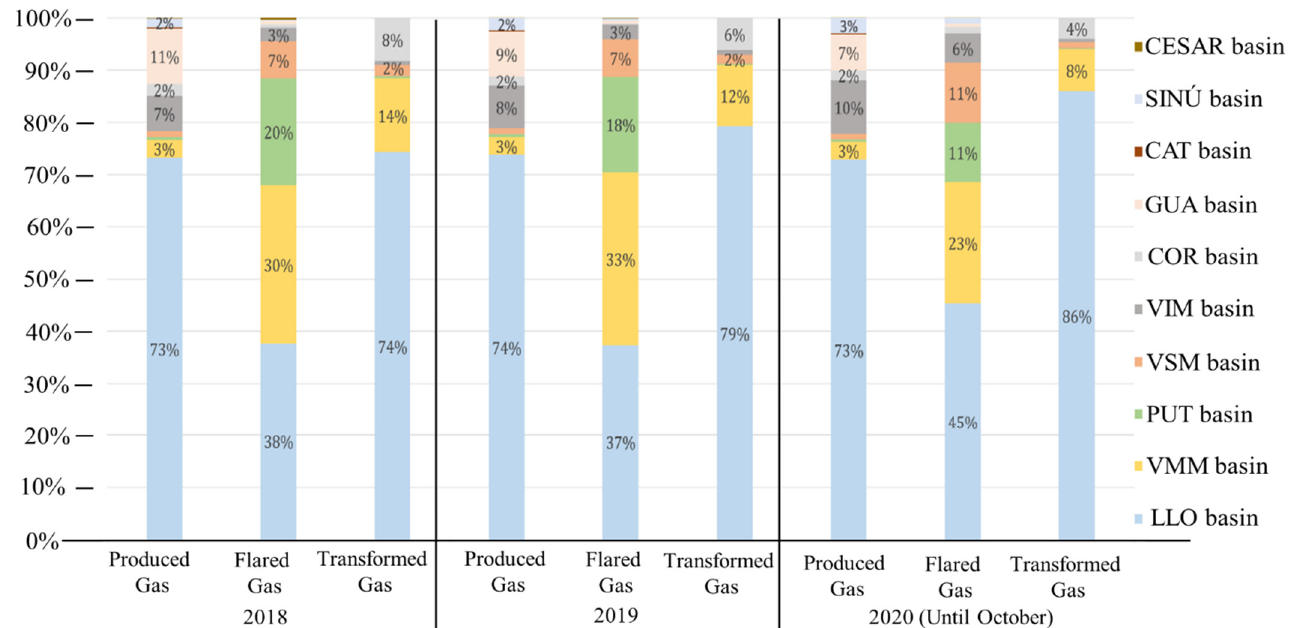
Figure 1. Flared, produced, and transformed gas percentages in the years 2018 [6], 2019 [4], and until October 2020 [7] for the Colombian basins reported for the ANH.